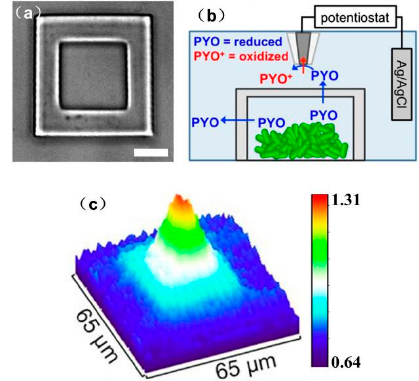
Figure 16. ( a ) Bright-field image of an empty 3D-printed microtrap. The trap as an 8-pL inner chamber (20 µ m × 20 µ m × 20 µ m; length × width × height) that is surrounded by four 8- µ m thick walls and a 3- µ m thick roof. (Scale bar: 10 µ m) ( b ) Schematic of the microtrap-SECM system for measuring PYO in real time. ( c ) A representative SECM image for pyocyanin (PYO) collected above a microtrap containing WT P. aeruginosa. Copyright (2014) National Academy of Sciences.